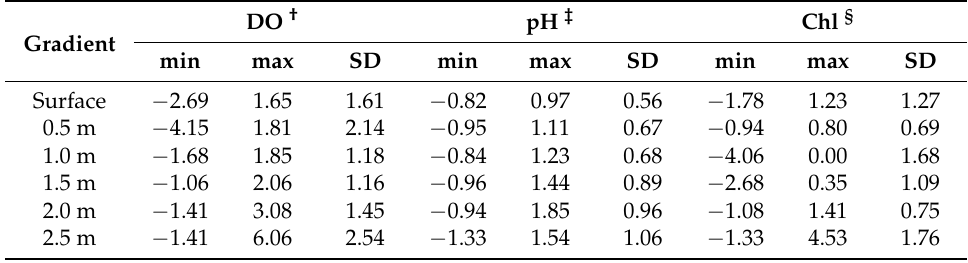
Table 3. Values of partial gradients of DO, pH and chlorophyll, expressed as relative values (unit · km − 1 ).